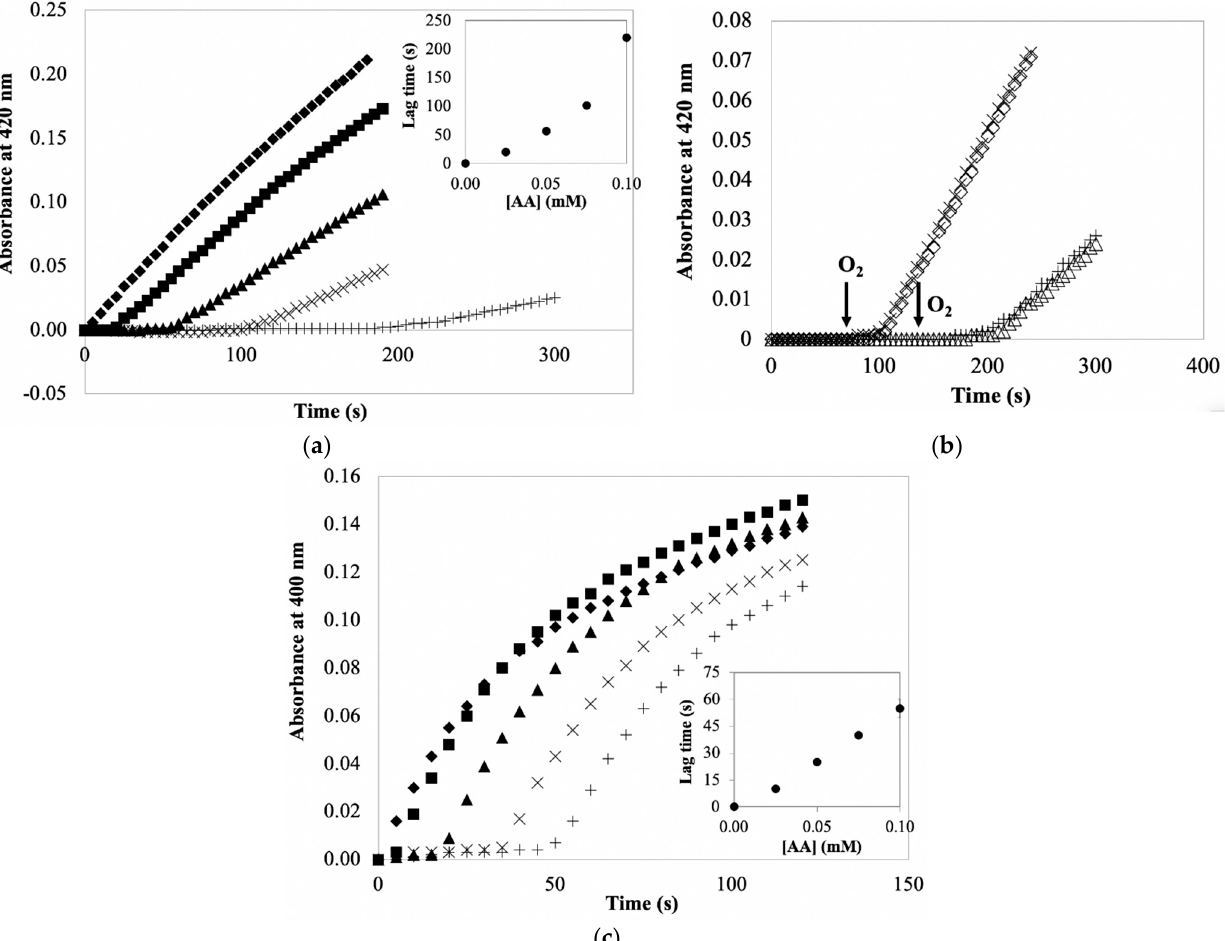
Figure 4. Representative time courses of product accumulation, depicted as an increase in absorbance, during activity measurements of potato PPO using catechol ( a , b ) and CA ( c ) as substrates. PPO reaction conditions were 5 mM catechol or 1 mM CA, 50 mM sodium phosphate buffer, pH 7.0, varying concentrations of AA ( ◆ , 0 mM; ■ , 0.025 mM; ▲ , 0.05 mM; ×, 0.075 mM; +, 0.1 mM). Reactions were initiated by adding 0.1 mL semi-purified PPO preparation to 2.1 mL reaction mixture. ( b ) Reaction conditions were as in ( a ), with the exception of adding O 2 by 10 s shaking PPO reaction mixtures containing AA ( ◇ , 0.075 mM and △ , 0.1 mM) at 1 min or 2 min, respectively, after initiation of the enzyme reaction. Insets in ( a , c ) show the relationship between AA concentration and the length of the lag phase.